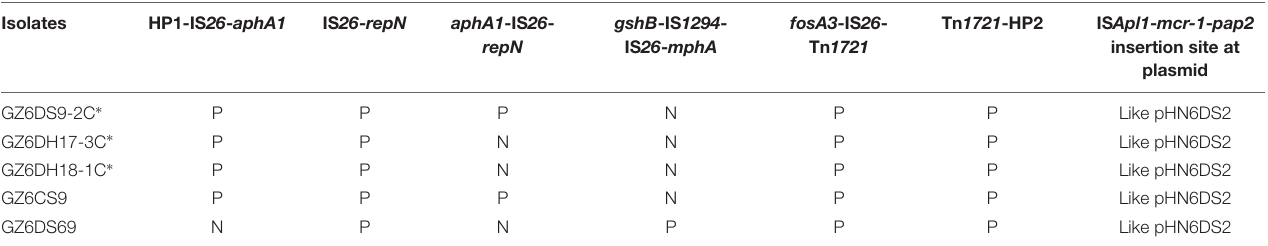
FIGURE 3 | Genetic organization of the multiresistance region of plasmid pHN6DS2, and structural comparison with other mcr-1 -carrying plasmids. The extents and directions of antibiotic resistance (thick arrows) and other genes are indicated. (cid:49) indicates a truncated gene or mobile element. ISs are shown as boxes labeled with their name. Labeled vertical arrows with IS boxes indicate the insertion sites of IS elements. Direct repeats are indicated by arrows and sequence. Tall bars represent the 38 bp inverted repeat (IR) of transposons. The backbone is indicated by dotted lines. TABLE 3 | Characteristics of pHN6DS2-like plasmids in this